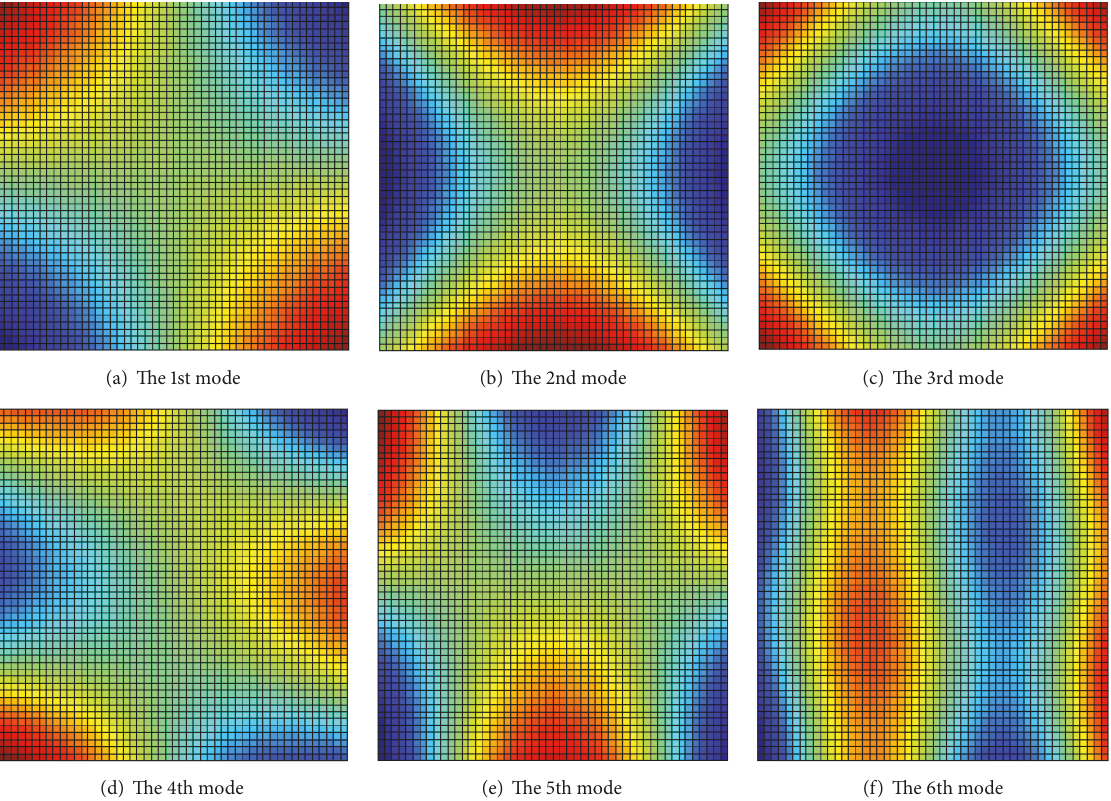
= 𝜉 = 10 2 , 𝜉 = 0 , 𝐾 𝑖 𝐾 𝑖𝑗 𝑖